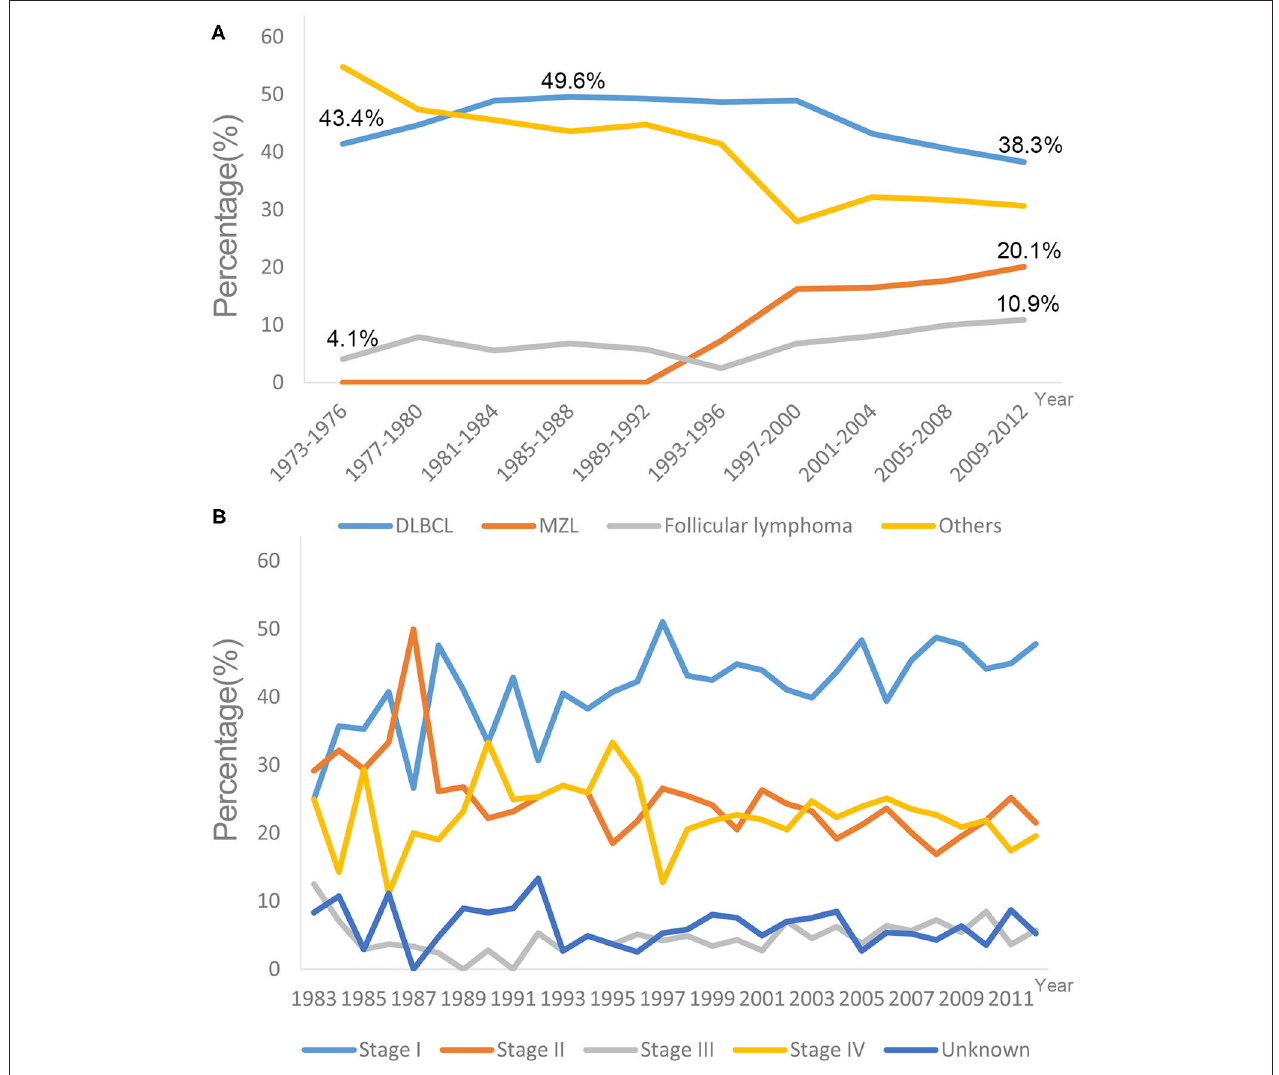
FIGURE 2 | Trends in different lymphoma subtypes (A) and tumor stages (B) at diagnose in SEER 18 registries, 1973–2012. DLBCL, Diffuse large B-cell lymphoma; MZL, Marginal zone lymphoma.